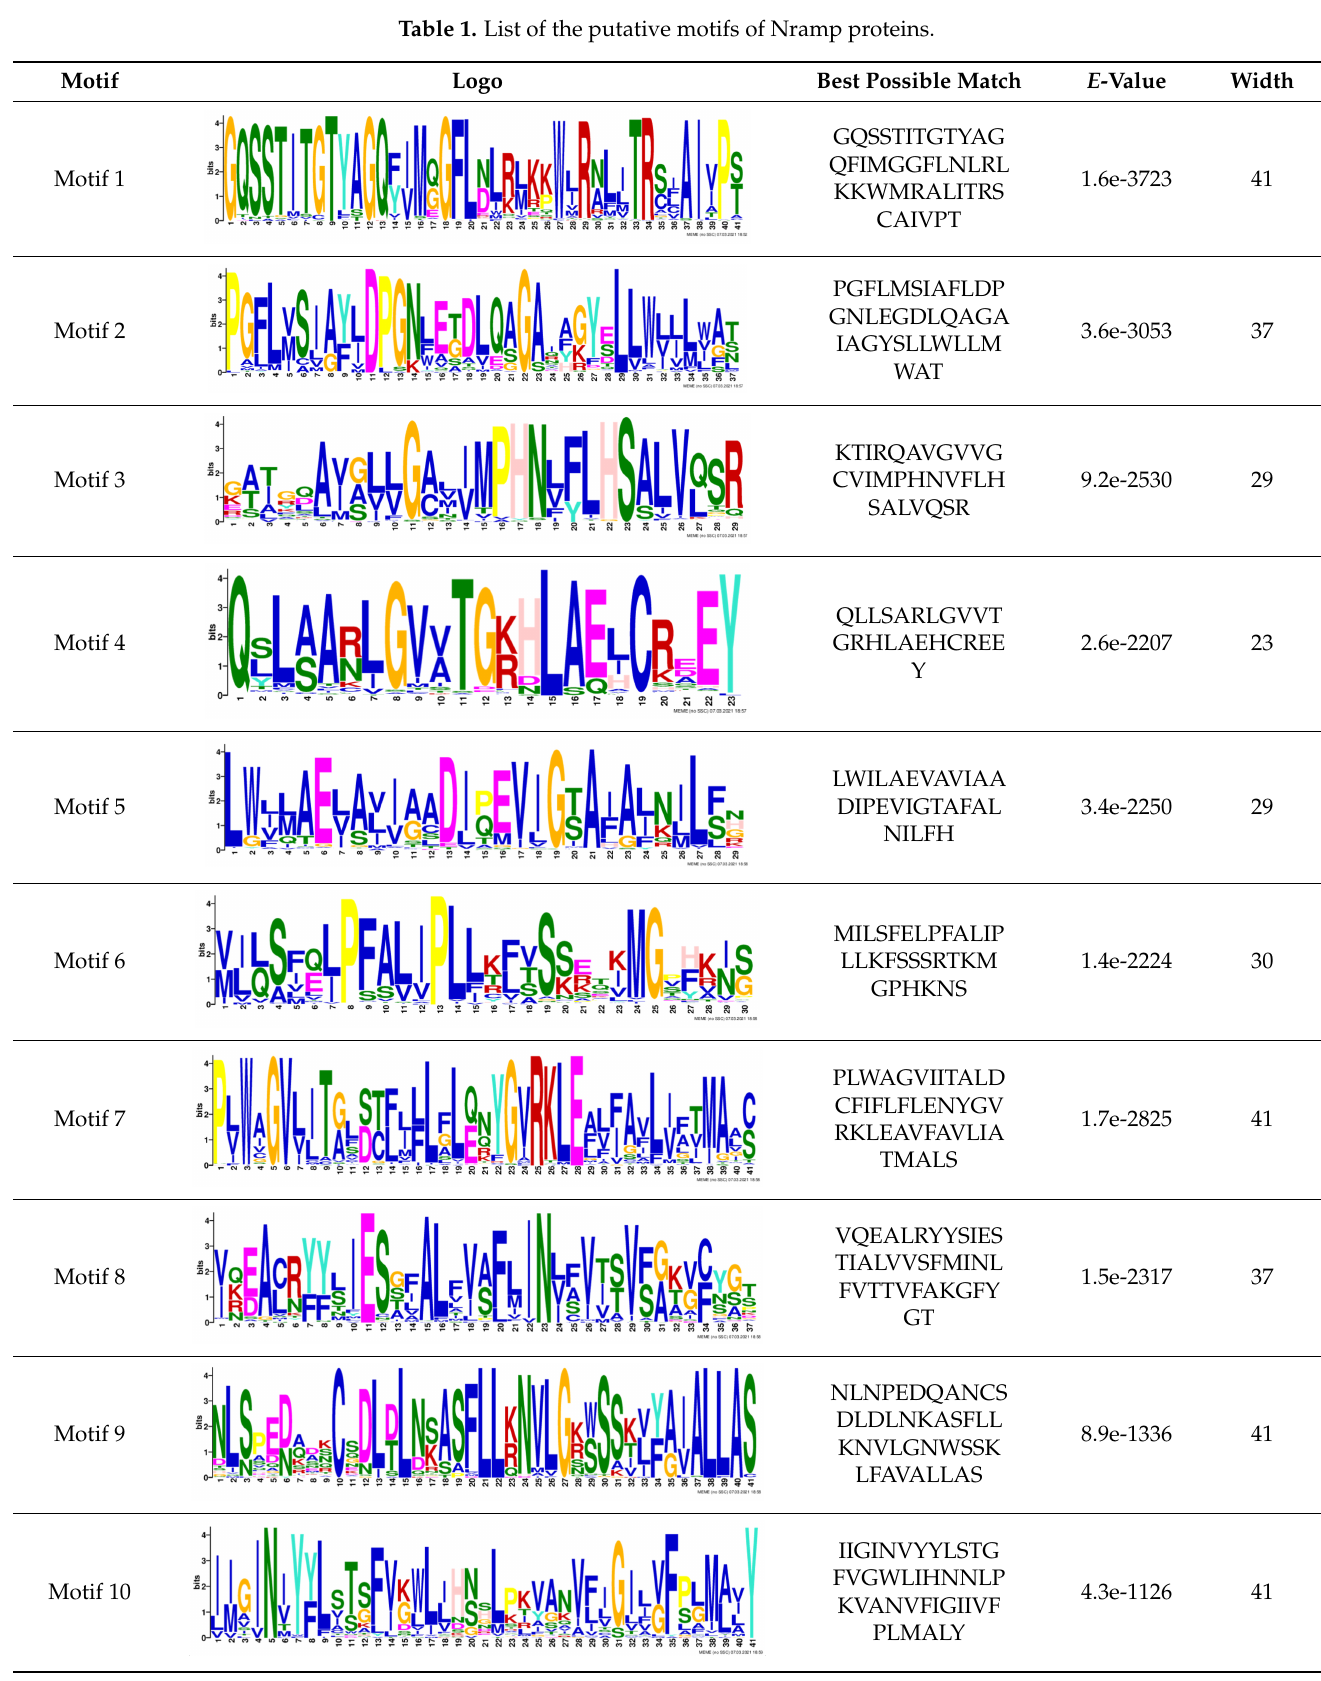
(Figure 2). The evolution of multigene families was conducted on gene structural diver- sity to some degree [52]. According to the map, NnNramp1 had the largest length (~ 74 kb) with 14 coding regions. HsNramp2 had the maximum coding regions (16) with ~ 48 kb, whereas SMF3 had the minimum length (1422 bp) coding regions (1). In addition,